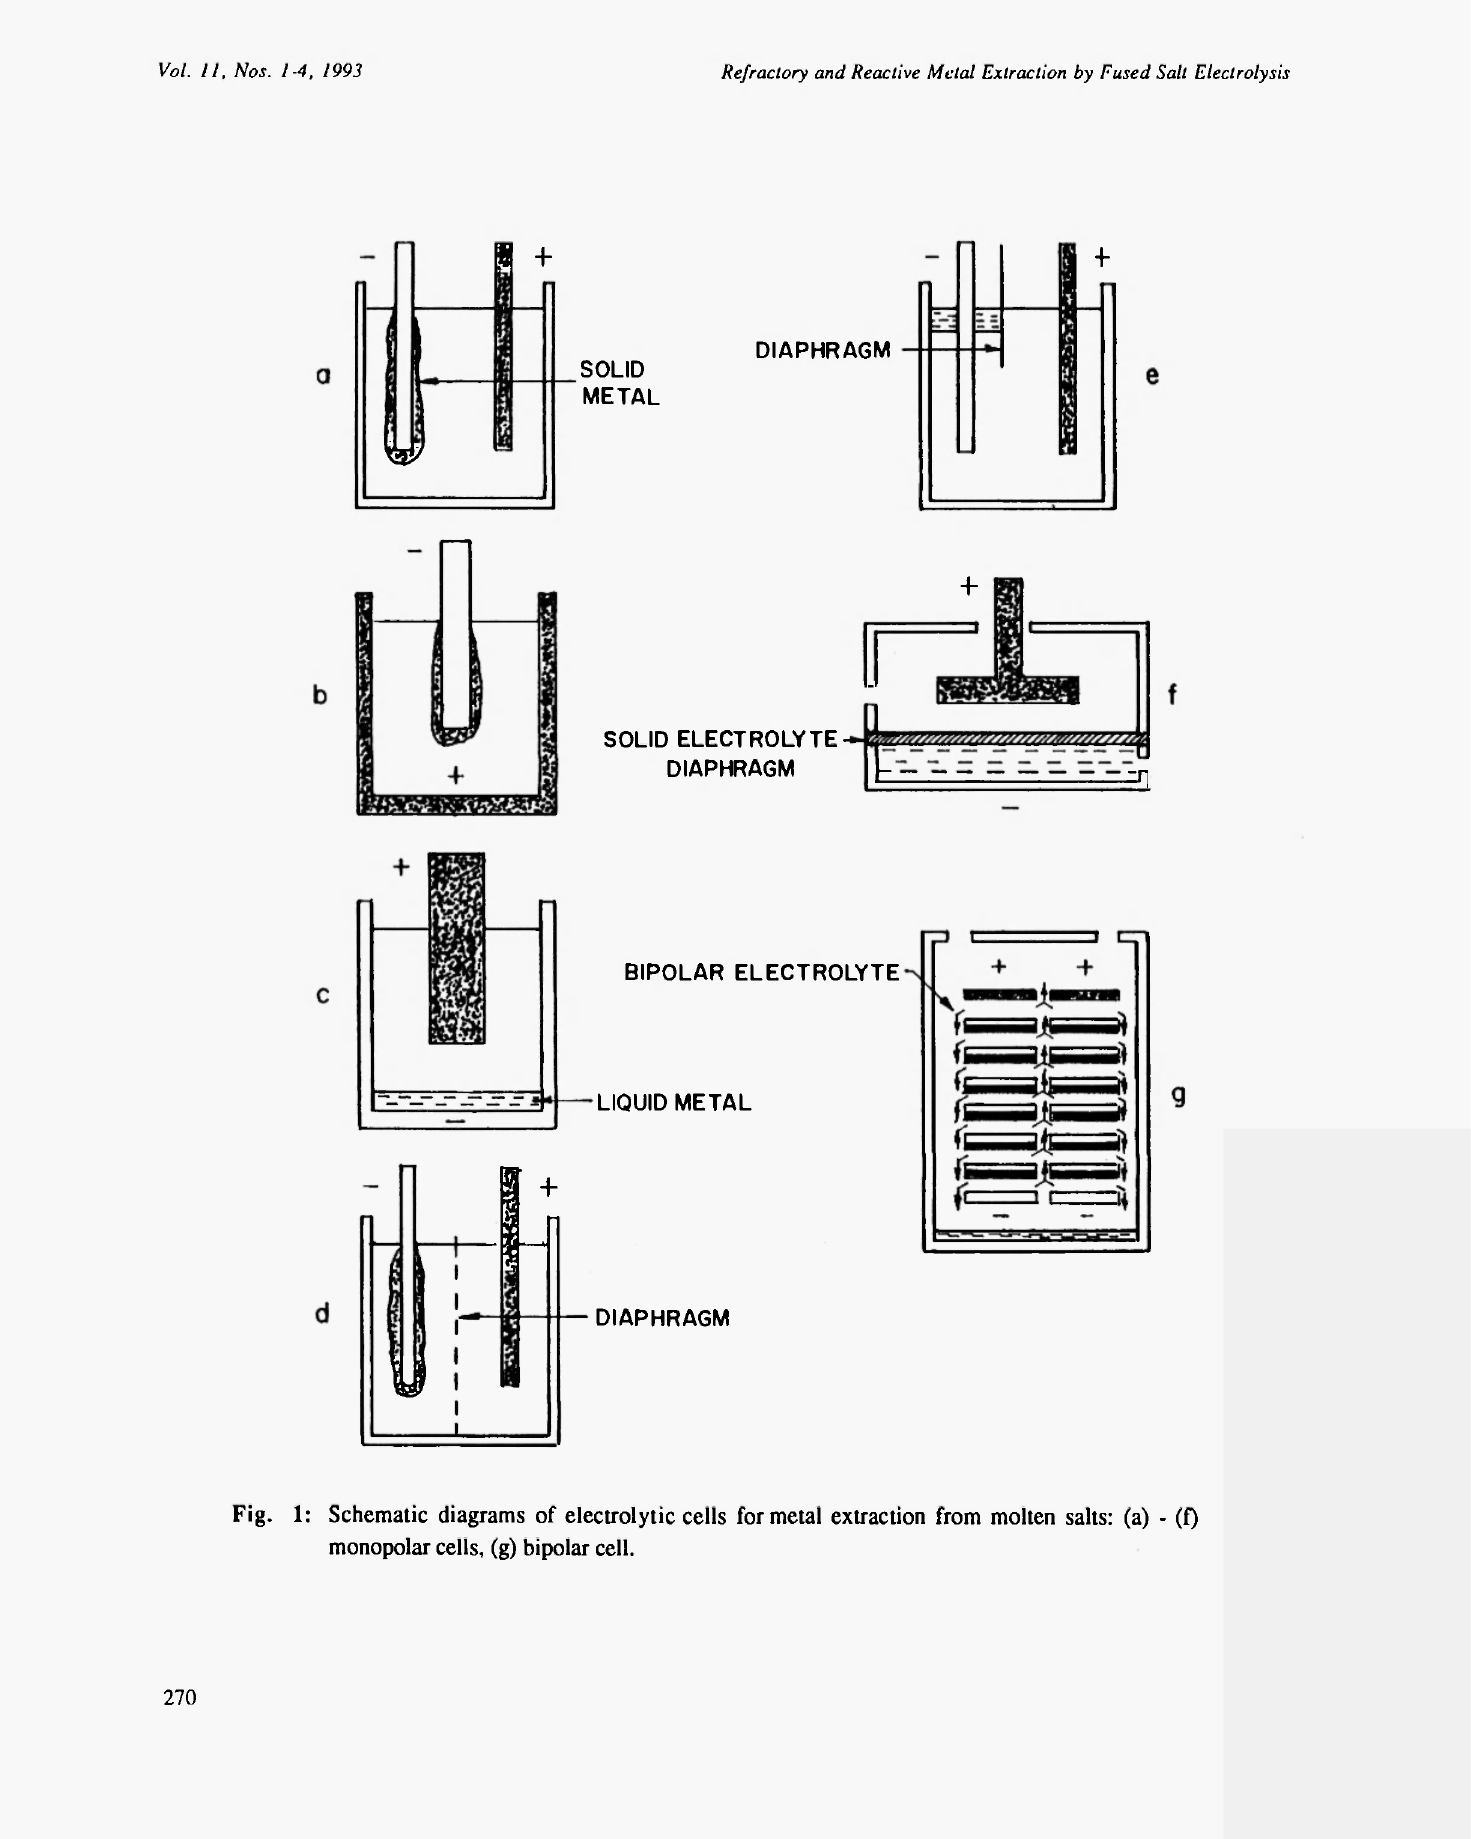
Fig. 1: Schematic diagrams of electrolytic cells for metal extraction from molten salts: (a) - (0 monopolar cells, (g) bipolar